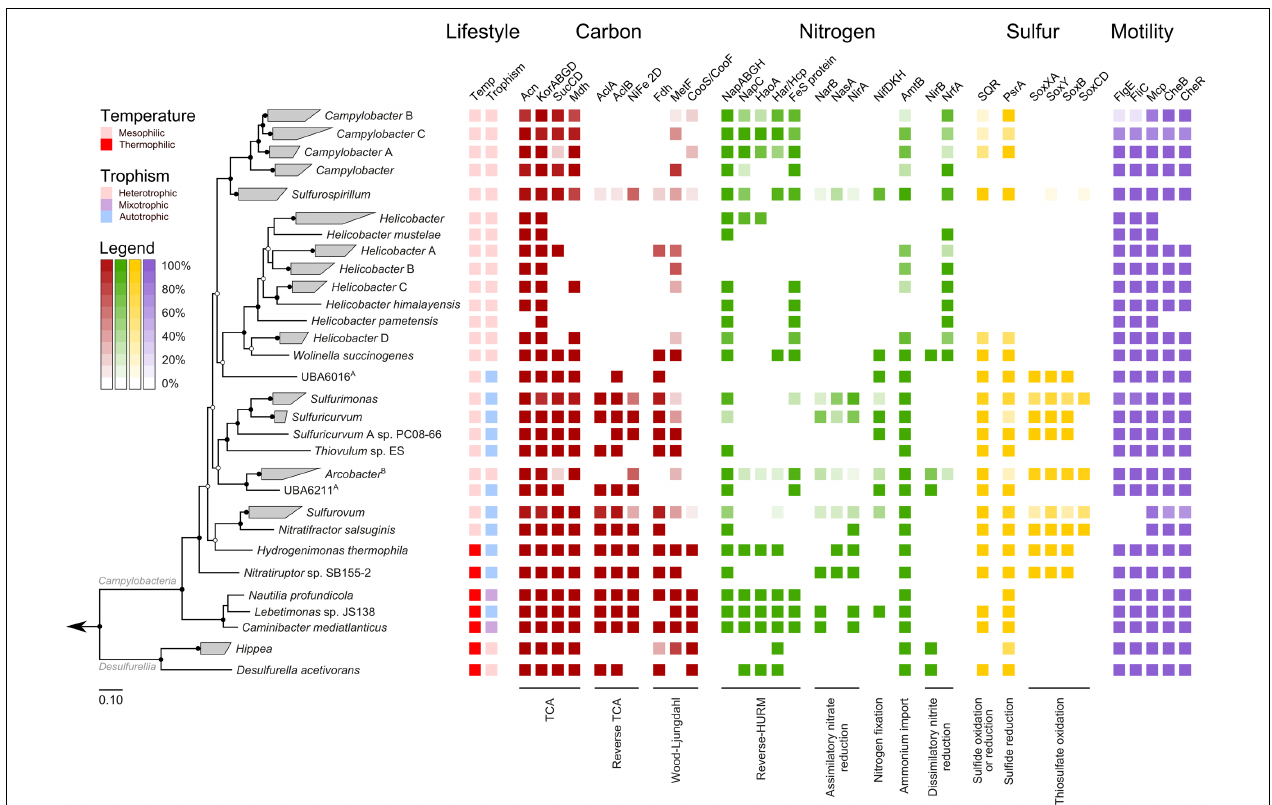
FIGURE 3 | Habitat and functional annotation of selected Epsilonbacteraeota pathways. Tree topology is that of Figure 2 , collapsed at the genus level. Cell intensity reflects the proportion of genomes within a clade that possessed the column function. A: Trophism is inferred from genomic data. B: Although some members of Arcobacter are capable of autotrophic growth (discussed in text) all genomes in this study were obtained from heterotrophic species. Column descriptions are as follows: Carbon pathways: aconite hydratase (Acn), 2-oxoglutarate oxidoreductase alpha-, beta-, gamma-, and delta- subunits (KorABGD), succinyl-CoA synthetase alpha and beta subunits (SucCD), malate dehydrogenase (Mdh), ATP citrate lyase alpha subunit (AclA) and beta subunit (AclB), [NiFe] hydrogenase family 2D (NiFe 2D), formate dehydrogenase (Fdh), methylenetetrahydrofolate reductase (MetF) and carbon-monoxide dehydrogenase catalytic and iron sulfur subunits (CooS/CooF). Nitrogen pathways: periplasmic nitrate reductase components NapA, NapB, NapG, and NapH (NapABGH), periplasmic nitrate reductase c-type cytochrome (NapC), hydroxylamine oxidoreductase (HaoA), hydroxylamine reductase/hybrid cluster protein (Har/Hcp), predicted reductive Fe-S protein (FeS protein), ferredoxin-nitrate reductase (NarB), assimilatory nitrate reductase (catalytic subunit, NasA), ferredoxin-nitrite reductase (NirA), nitrogenase molybdenum-iron (alpha- and beta-chains) and iron protein (NifDKH), ammonium transporter (AmtB), nitrite reductase (NADH) large subunit (NirB), cytochrome c nitrite reductase (NrfA). Sulfur pathways: sulfide:quinone oxidoreductase (SQR), polysulfide reductase chain A (PsrA), thiosulfate oxidating Sox proteins (SoxXA, SoxY, SoxB, SoxCD). Motility: flagellar hook protein (FlgE), flagellin (FliC), methyl-accepting chemotaxis protein (Mcp), chemotaxis response regulator (CheB), chemotaxis methyltransferase